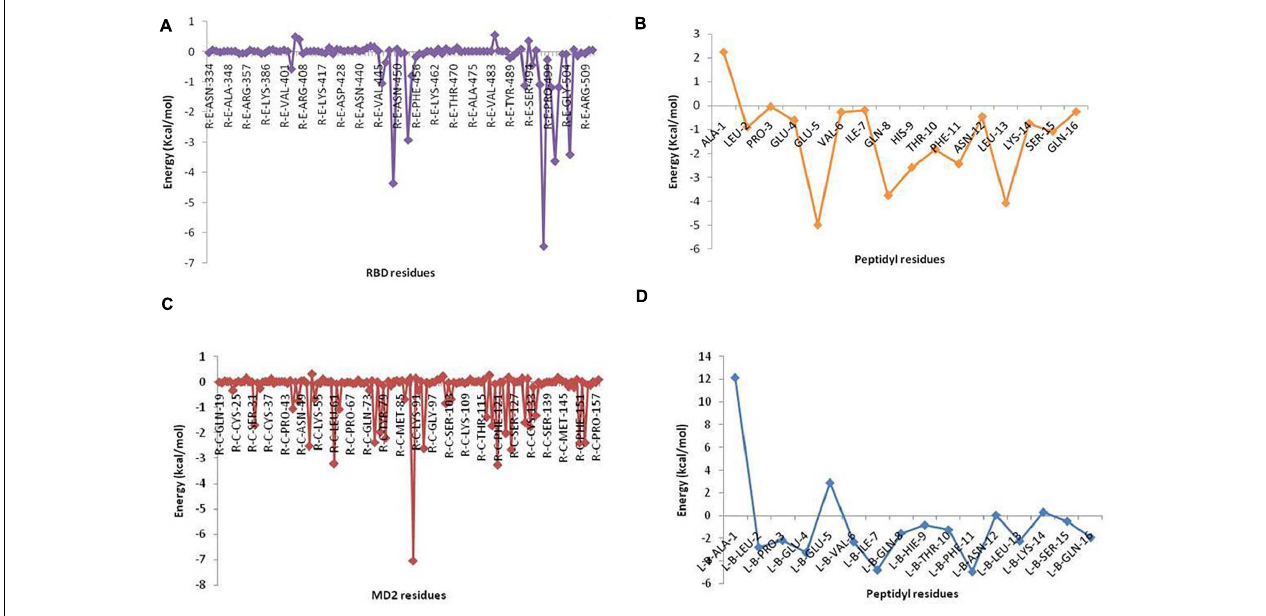
FIGURE 6 | Binding free energy contribution of (A) RBD residues and (B) P13 residues in P13-RBD complex, and (C) MD2 residues and (D) P13 residues in P13-TLR4/MD2 complex. Energies were computed from MM/GBSA analysis.